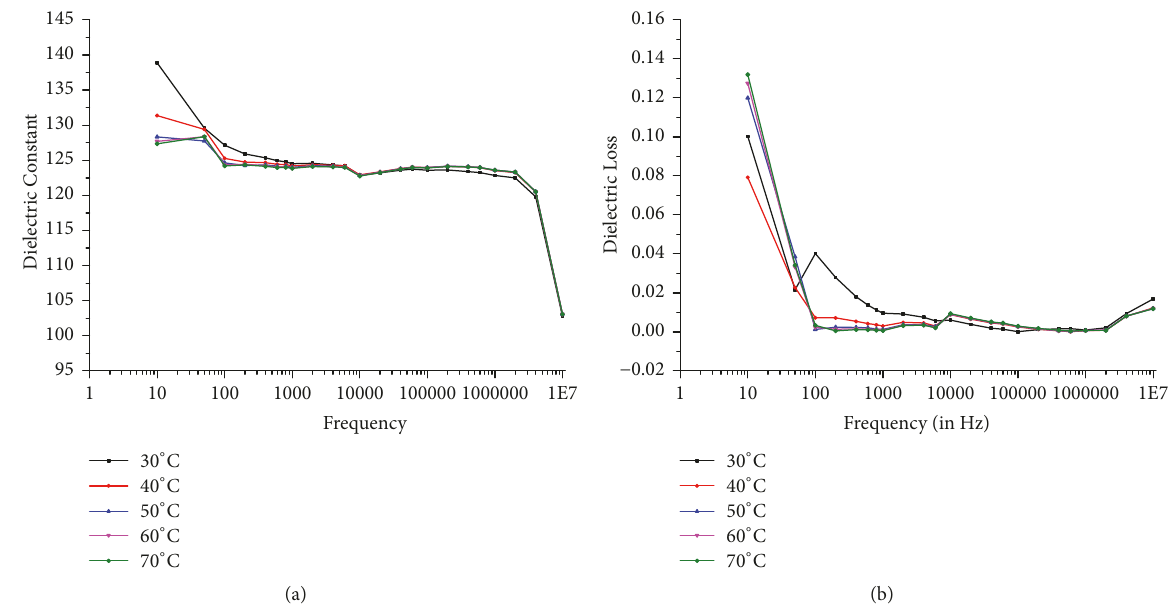
Figure 11: (a) Dielectric constant vs. frequency. (b) Dielectric loss vs. frequency measured at different temperatures.